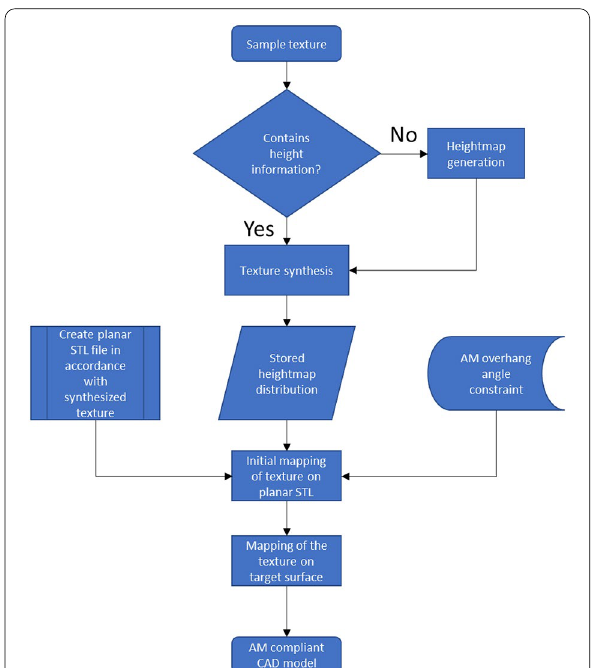
Figure 1 Flowchart of the implemented